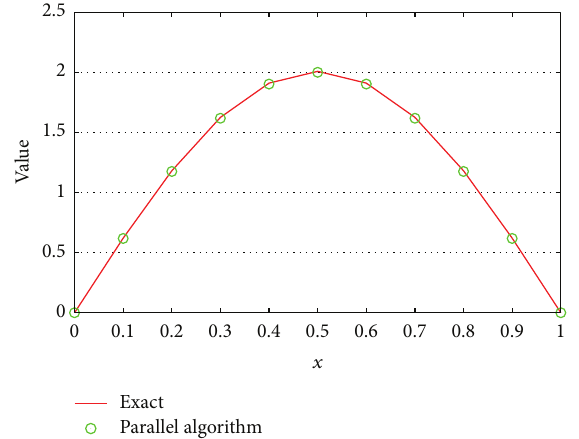
Figure 6: Comparison of exact solution to the solution of the parallel algorithm at time t = 1.0.